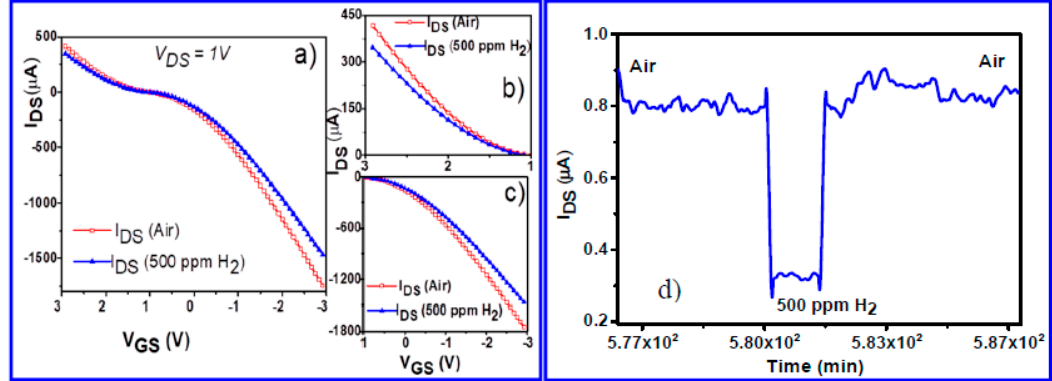
Figure 3 . ( a ) I DS vs V GS sensor response of back-Gated FET sensor under synthetic air (open square) and 500 ppm H 2 (triangle) gas exposures, at constant V DS = 1 V; the insets ( b , c ) shows the sensor responses for V GS = 3 V to 1 V and 1 V to − 3 V, respectively; ( d ) sensor response to 500 ppm H 2 gas exposure extracted at constant, V GS = 3 V and V DS = 1